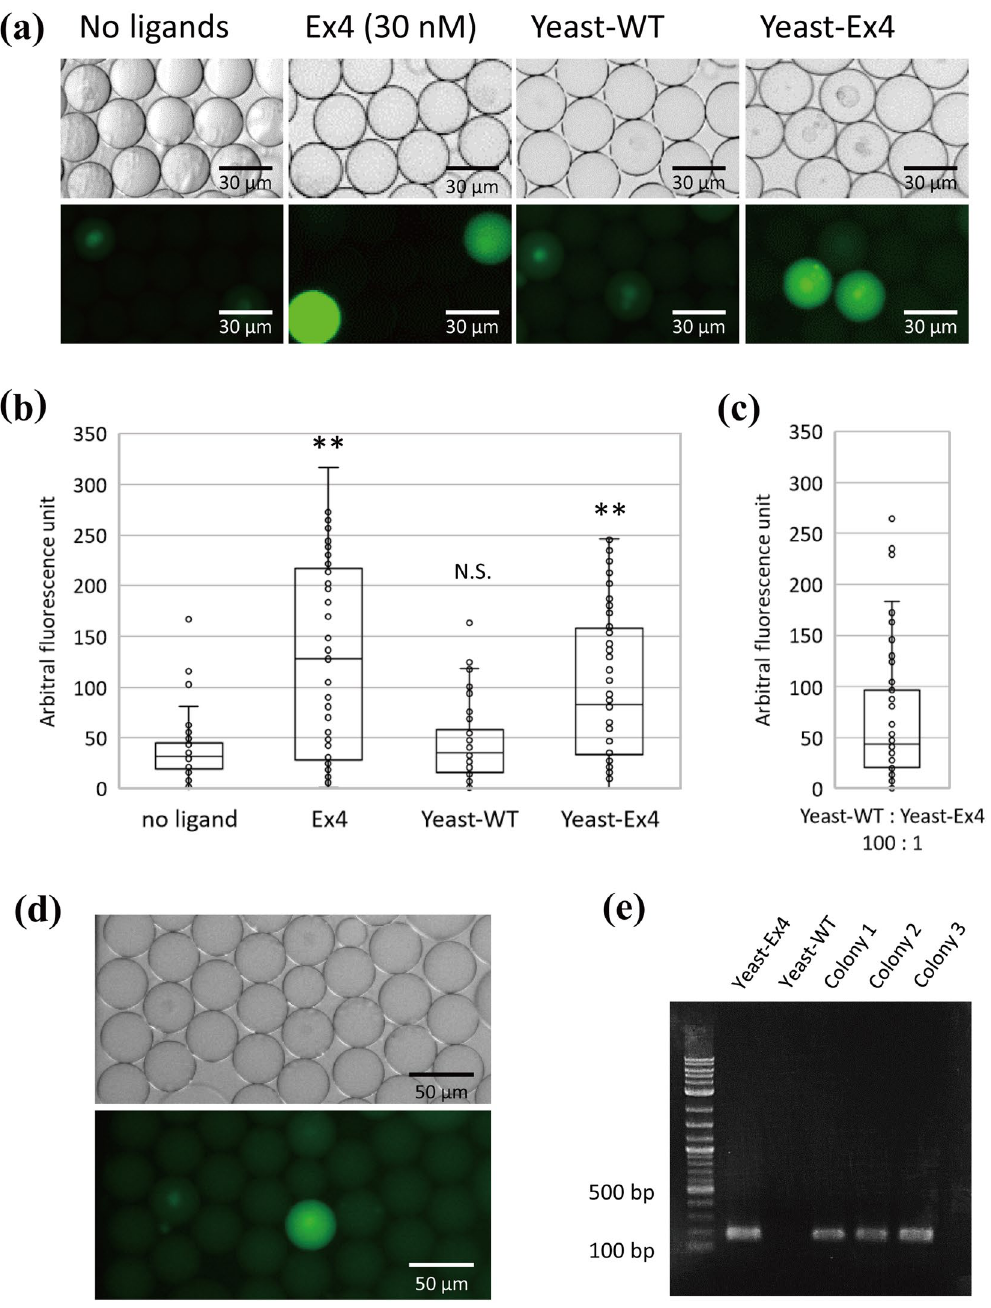
Figure 4. High-throughput functional cell-based assay using droplet microfluidics. ( a ) Representative fluorescence micrographs of droplets. The hGLP1R/LacZ-293 cells were encapsulated with no ligand, 30 nM authentic Exendin-4 (Ex4), WT yeast cells (Yeast-WT, 9.1 × 10 6 cells/mL), or yeast cells producing Ex4 (Yeast-Ex4, 9.1 × 10 6 cells/mL.). The images show the bright field images (upper image) and the fluorescence images (lower image). ( b ) Box plots of fluorescence intensity of each droplet in the experiment of ( a ). We analyzed at least 70 droplets containing a reporter cell for all samples. Statistical significance was determined by two-tailed Student’s t -test ( ** p < 0.01). N.S., not significant. ( c ) Box plots of fluorescence intensity of droplets. The hGLP1R/LacZ-293 cells were encapsulated with a mixture of yeast-WT cells and yeast-Ex4 cells at a ratio of 100:1. ( d ) A representative fluorescence image of droplets in the experiment of ( c ). The images show the bright field image (upper image) and the fluorescence image (lower image). ( e ) A colony-direct PCR was performed on yeast cells isolated in the experiment of ( c , d ). To determine whether colonies isolated from the strongly fluorescent droplet were yeast-WT or yeast-Ex4, a colony-direct PCR was performed on isolated cells. Yeast-Ex4 and yeast-WT were used as a positive control and a negative control,